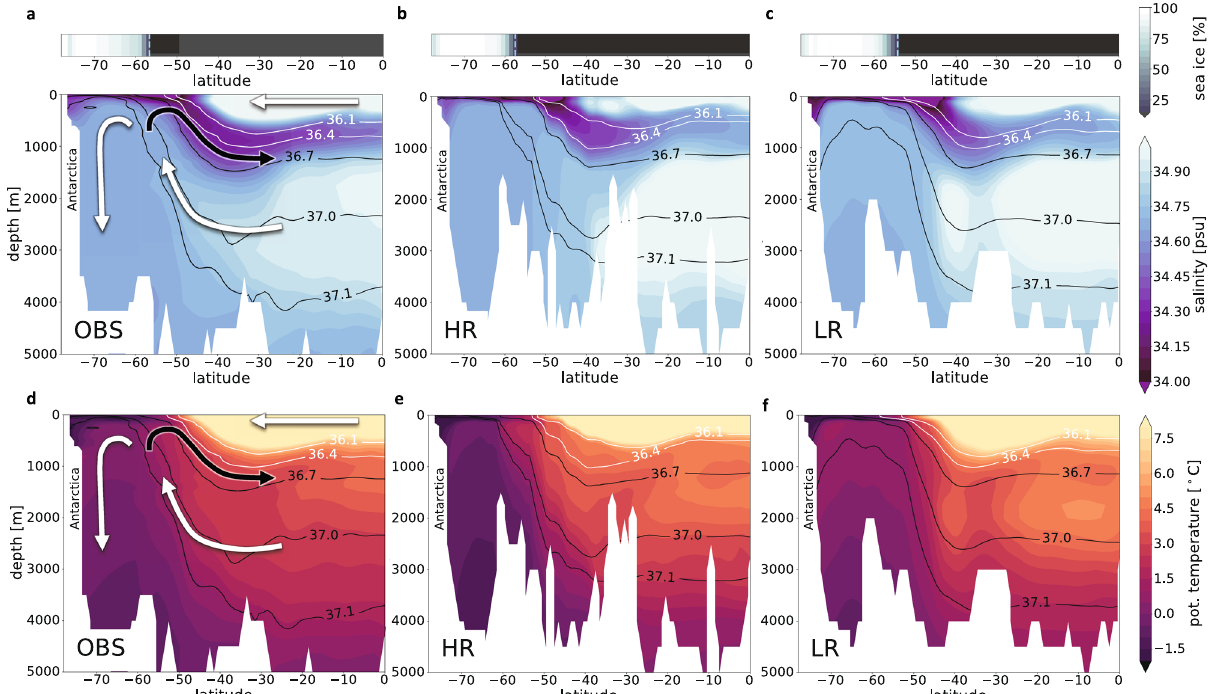
Fig. 4 Southern Ocean sea-ice fraction [%], salinity [psu], and potential temperature [°C] sections along the 30° W meridian in present-day observations and in model simulations (1990 – 2019). a , d Observations (OBS) from the National Snow and Ice Data Centre NSIDC 98 (September sea-ice fraction) and from the Polar science centre Hydrographic Climatology PHC 3.0 92 (salinity and potential temperature), overlaid with a schematic representation of the residual overturning circulation (arrows), b , e simulated water mass structure and sea-ice fraction for the high-resolution con fi guration (HR), and c , f same for the low-resolution (LR) simulation. Dashed vertical lines denote the latitude of September sea-ice edges. For better orientation between the different panels, relevant density contours ( σ 2 -isopycnals) are highlighted (black and white lines). Black arrows depict the northward branch of the upper circulation cell of the residual overturning circulation that is connected to the prominent low-salinity layer of Antarctic Intermediate